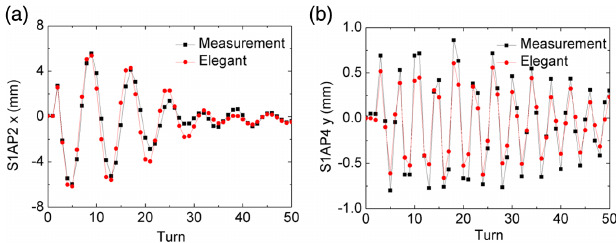
FIG. 2. Beam oscillation in horizontal (a) and vertical (b) planes following a 0.3 mrad kick in the horizontal plane for a 0.9 mA